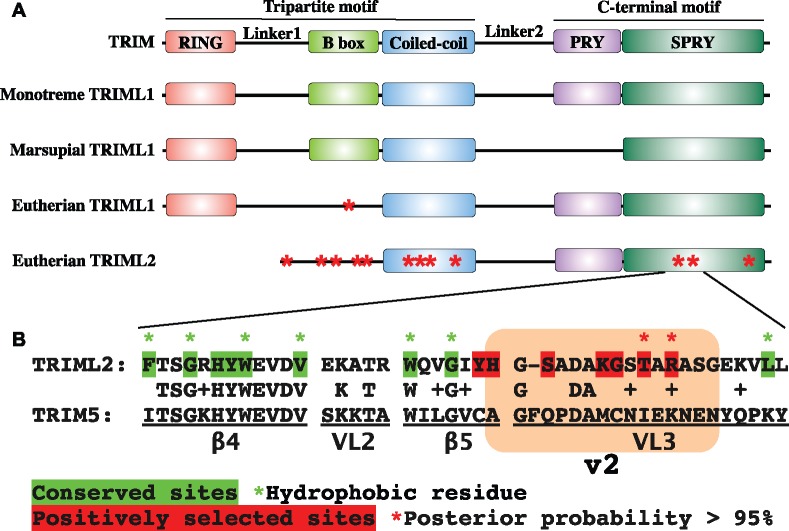
Sites under positive selection in TRIML1 and TRIML2. (A) Compared with monotreme and marsupial TRIML1, eutherian TRIML1 lacks the B-box domain, while TRIML2 lacks both the RING and the B-box domains. In TRIML1, the site under significant positive selection resides in B-box homologous region. In TRIML2, sites under significant positive selection concentrate in B-box homologous region, coiled-coil domain and PRY/SPRY domain. (B) Alignment of human TRIML2 and TRIM5. Positively selected sites (red) cluster in the specificity-determining v2 region (orange shade) and are flanked by conserved sites (green) that contribute to the hydrophobic core of TRIM’s canonical binding interface.